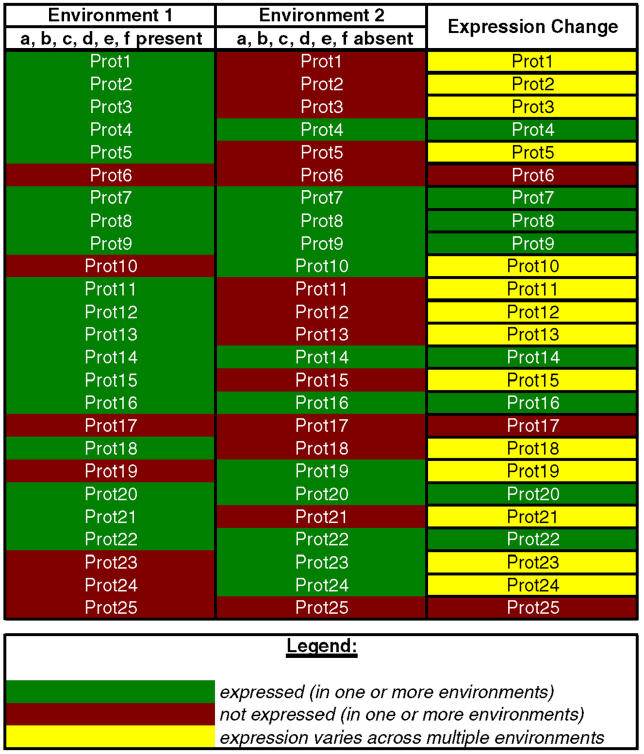
In Silico Expression Array for the Prototypic TRSThe expression of genes is evaluated across two different environments using extreme pathway analysis. The first column depicts the expression state for an environment in which all six metabolites are present. The second column depicts the expression state for an environment in which all six metabolites are absent. For both columns, the proteins shaded in green are transcribed, whereas those in red are not transcribed. The third column illustrates an in silico expression analysis: the expression states of the two environments are compared, and changes in expression are illustrated in yellow, as described in the legend box on the figure.